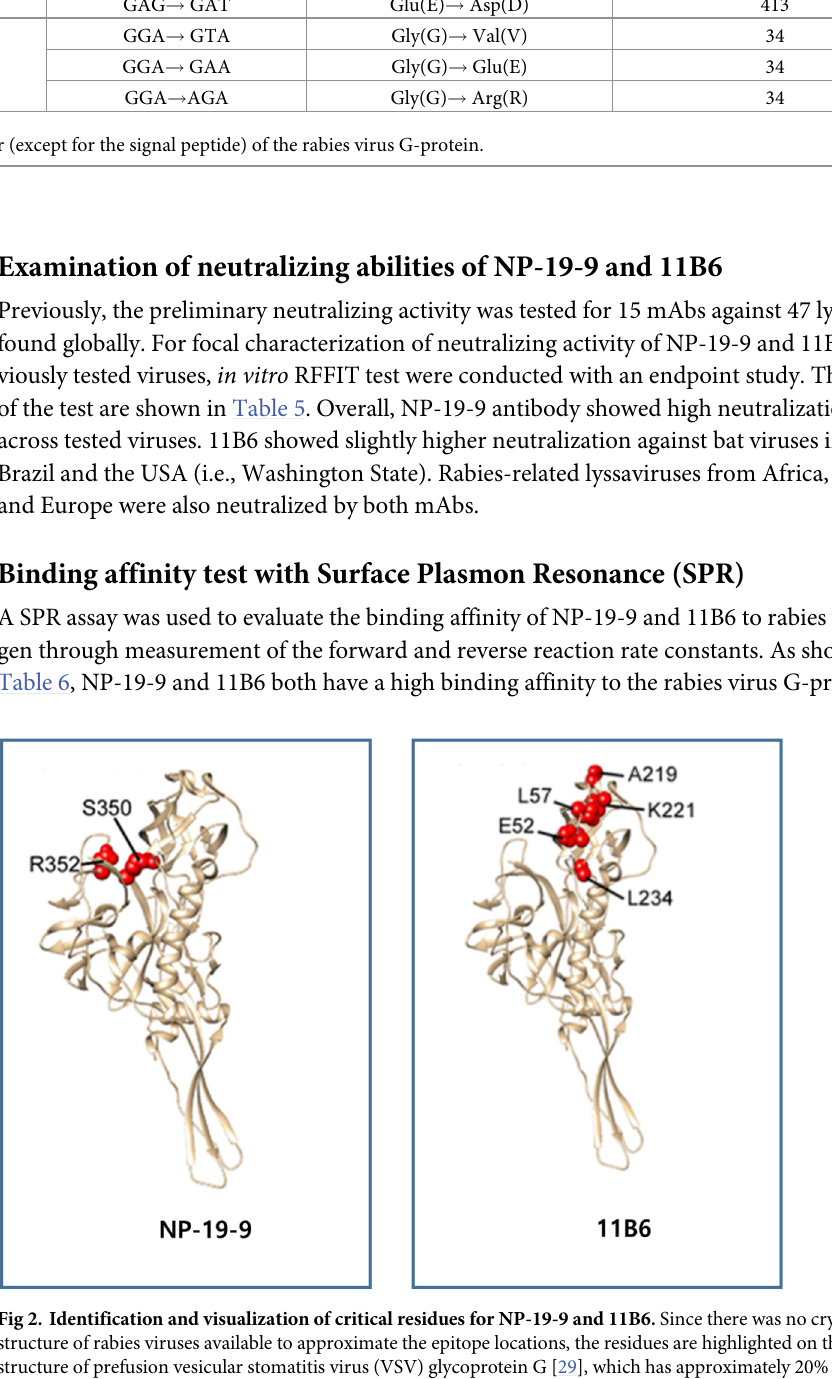
Fig 2. Identification and visualization of critical residues for NP-19-9 and 11B6. Since there was no crystal structure of rabies viruses available to approximate the epitope locations, the residues are highlighted on the crystal structure of prefusion vesicular stomatitis virus (VSV) glycoprotein G [29], which has approximately 20% identity with rabies viruses. Critical residues that have no homologues on the VSV-G crystal structure (G53 and C54) were not